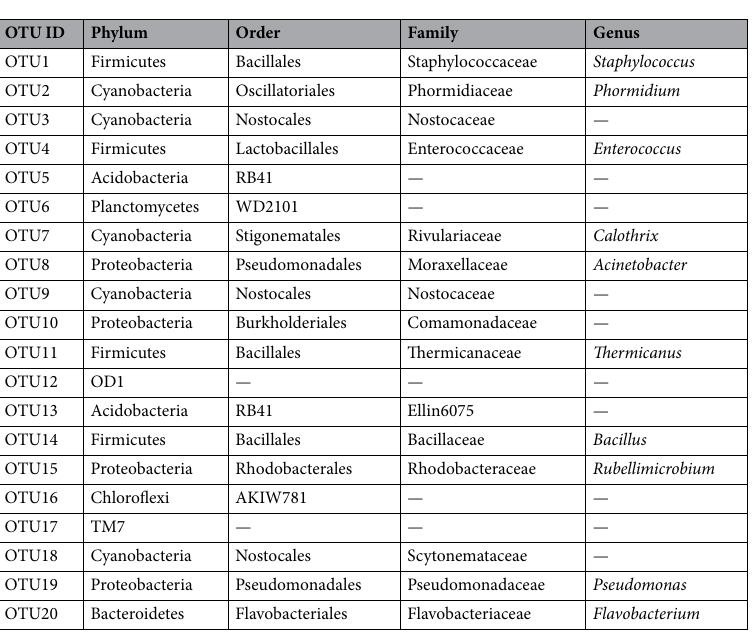
Table 2. Taxonomic identification of the 20 most abundant OTUs detected by 16S rRNA